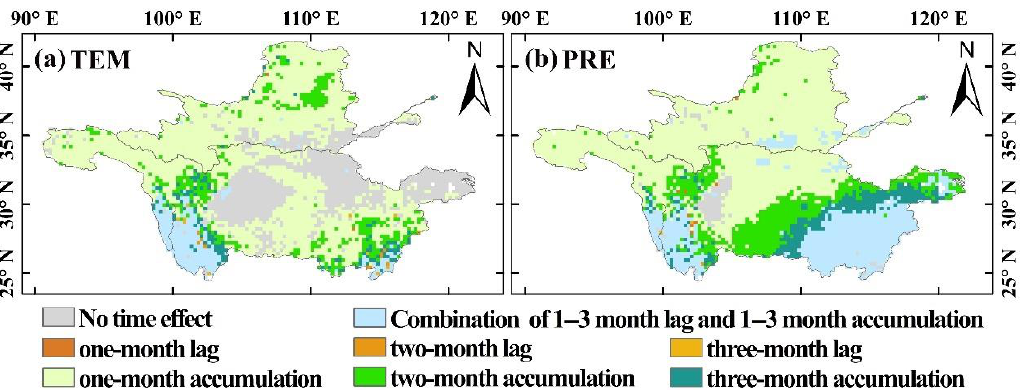
Figure 6. Time effects of each climatic factor identified by the maximum determination coefficient.